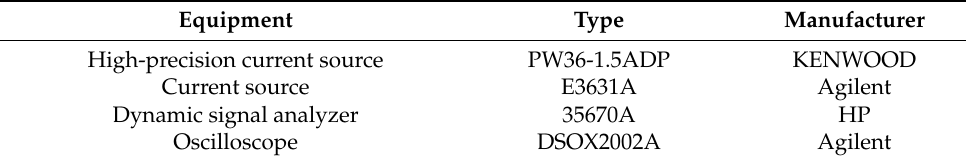
Table 2. Device used by silicon gyroscope sensor test system.